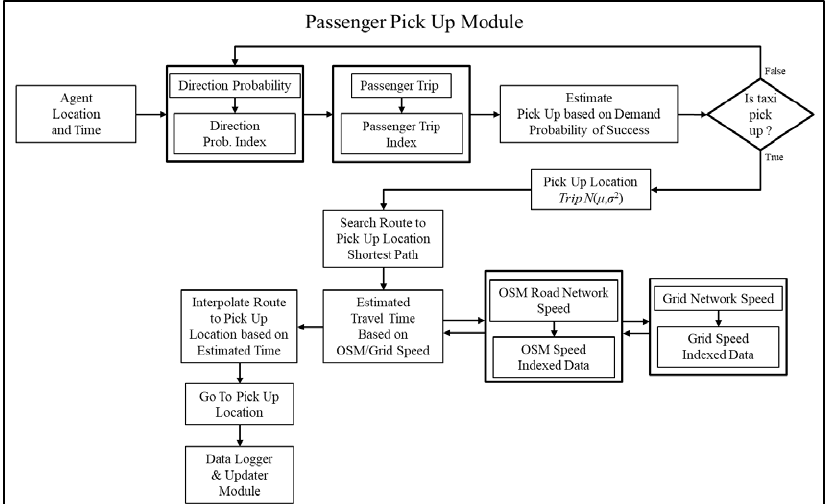
Figure 14. Passenger pick-up